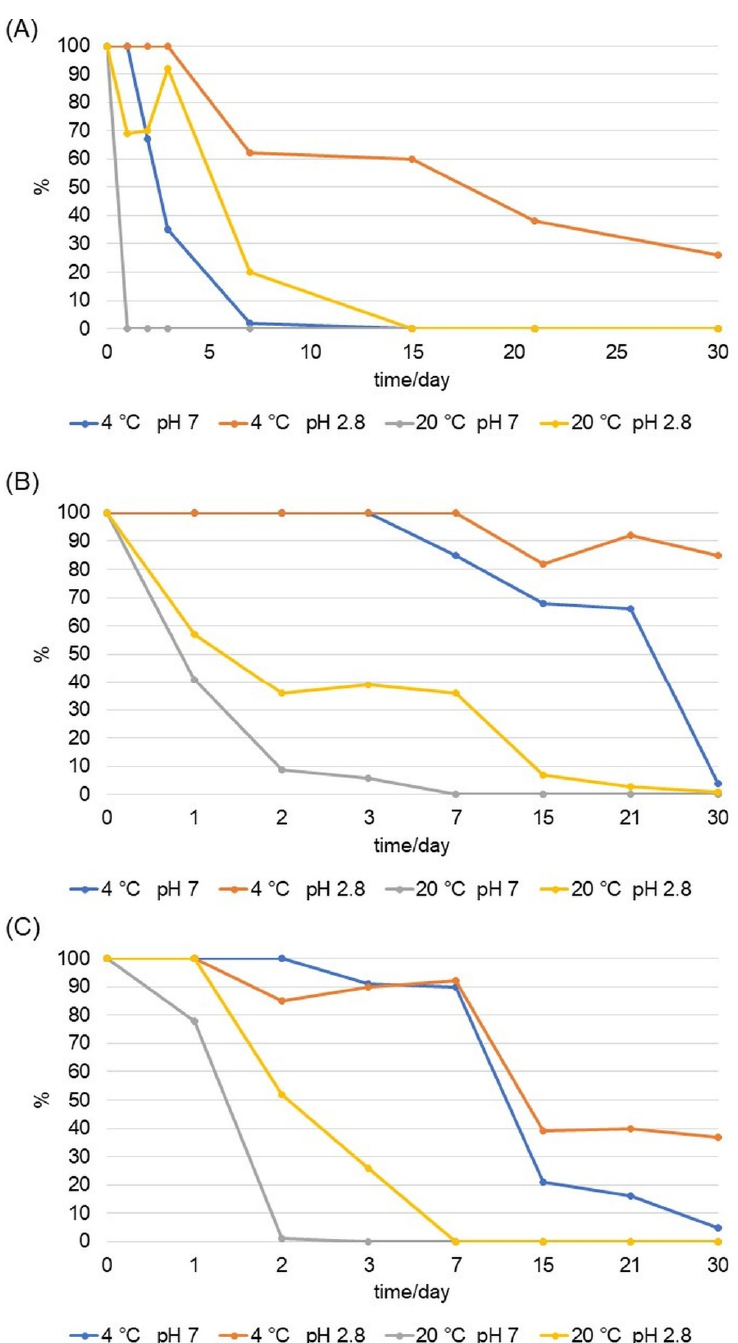
Figure 8. MS/MS stability of AA ( A ), NH 2 AA (D1) ( B ), and CH 3 NHAA (D2) ( C ) in neutral, acidic, and alkaline solvent. The figure shows the temperature (T), the pH of the compound solution, the percentage of the analyte detected in the sample, and the day of the analysis. The precursor ion of D1 is 175.8 m / z in the positive recording mode (Figure S5). The ion intensity after 30 days of experiment indicated approximately the same concentration level of D1 as on day 0 of the experiment. This is in correlation with the previous results that showed 85% of the detected analyte in the sample after 30 days of analysis (Figure